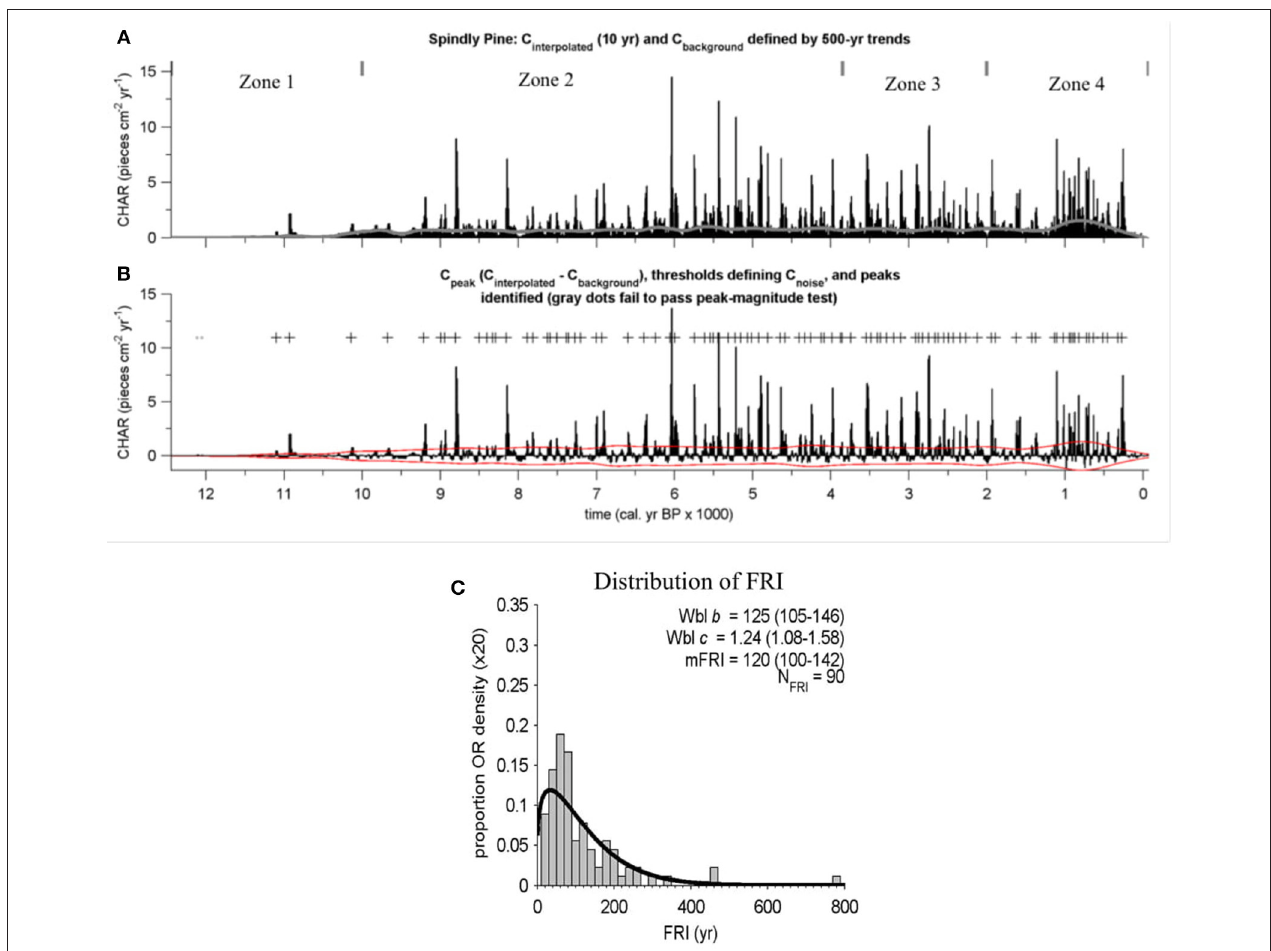
FIGURE 4 | (A) Charcoal accumulation (CHAR) in pieces cm − 2 year − 1 ; gray line represents background charcoal levels; (B) Peak identification with plus ( + ) symbols representing peaks/fire events and gray dots representing peaks that failed to pass the peak-magnitude test; (C) Distribution of fire return intervals (20-year bins) and Weibull model estimates (b and c parameters with 95% CI) The four zones plotted in (A) are based on constrained cluster analyses in CONISS using pollen percentage